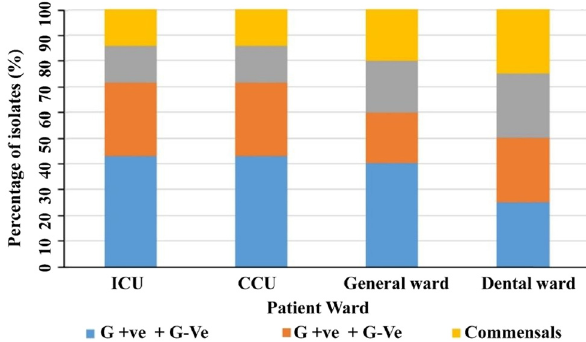
Figure 2: Collection of isolates from di ff erent wards. The number of isolates collected from various patient wards. Isolated Gram posi - tive and Gram negative